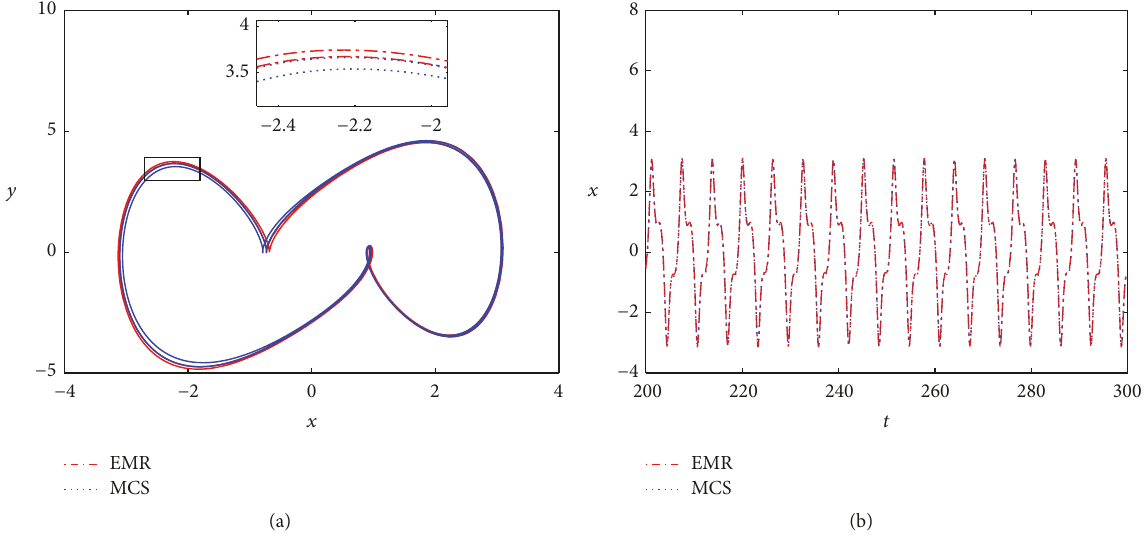
Figure 8: Period 2 𝑇 for 𝜎 = 0.06 : (a) phase portrait for EMR-MCS; (b) time history diagram for